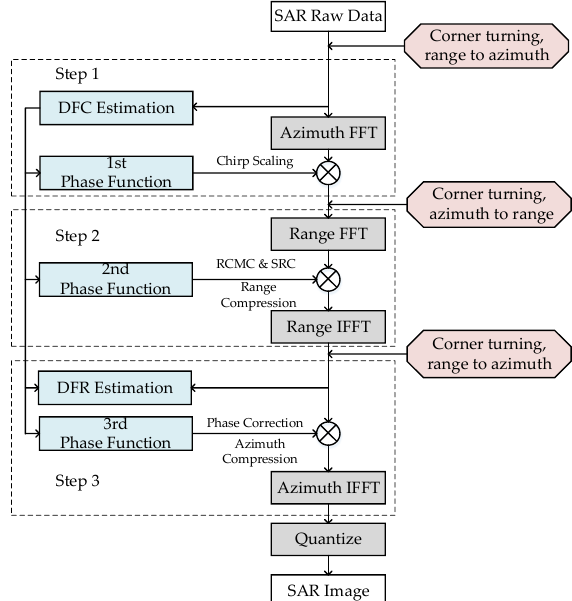
Figure 1. Flowchart of the chirp scaling (CS) algorithm.